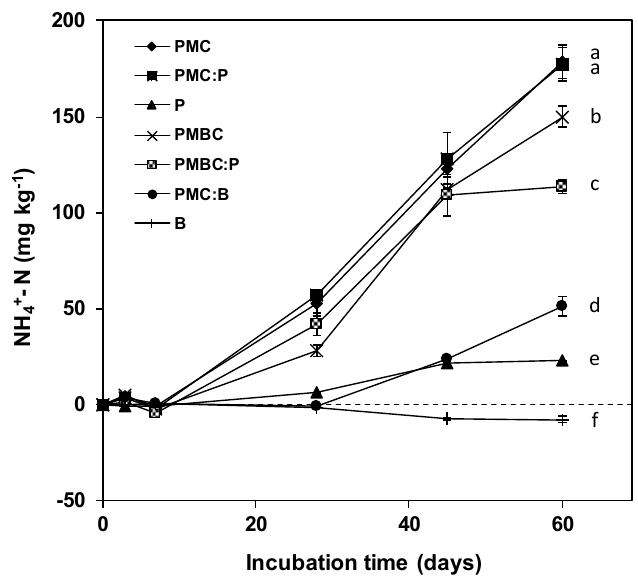
Figure 2. Concentrations of KCl- extracted ammonium (NH 4+ -N) from the materials (PMC = poultry manure composted without biochar; PMBC = poultry manure composted with biochar; P = peat; B = biochar) and their mixes (PMC:P, PMC:B and PMBC:P; 50%:50% by volume) during the incubation experiment. Three replicates (n = 3) were used for each substrate and date of analysis. Vertical bars in individual data indicate the standard error of the mean. Different letters indicate significant differences ( P < 0.05) between means for NH 4+ -N released at the end of the experiment according to one-way ANOVA and LSD test.